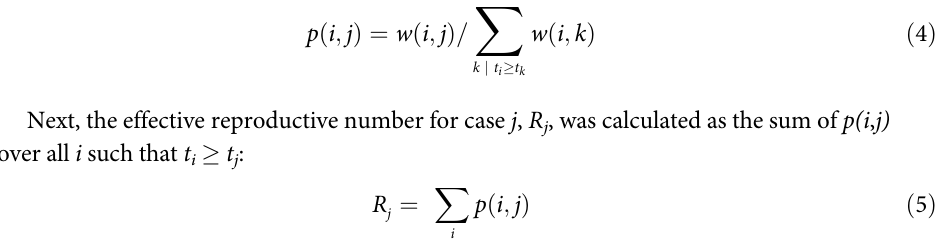
S1 Fig. Map of Kenya with county borders. Turkana County is outlined in orange. County fill color denotes the number of trips to or from the designated county. The Kitale bus terminal and Eldoret airport are marked with white points. The study area in Central Turkana is highlighted with an inset map of health facilities to which index cases reported. Shapefile